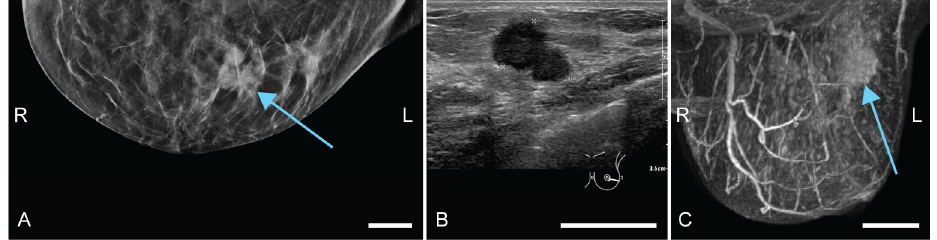
Fig 9. Case 4: Diagnostic images of an invasive carcinoma in the left breast. L and R indicate left and right, respectively. (A) Craniocaudal x-ray (CC-MMG). (B) Ultrasound (US) image. (C) MIP of the subtraction dynamic T1 MR acquisition, with adjusted window level and width values for enhanced contrast. All scale bars represent 20